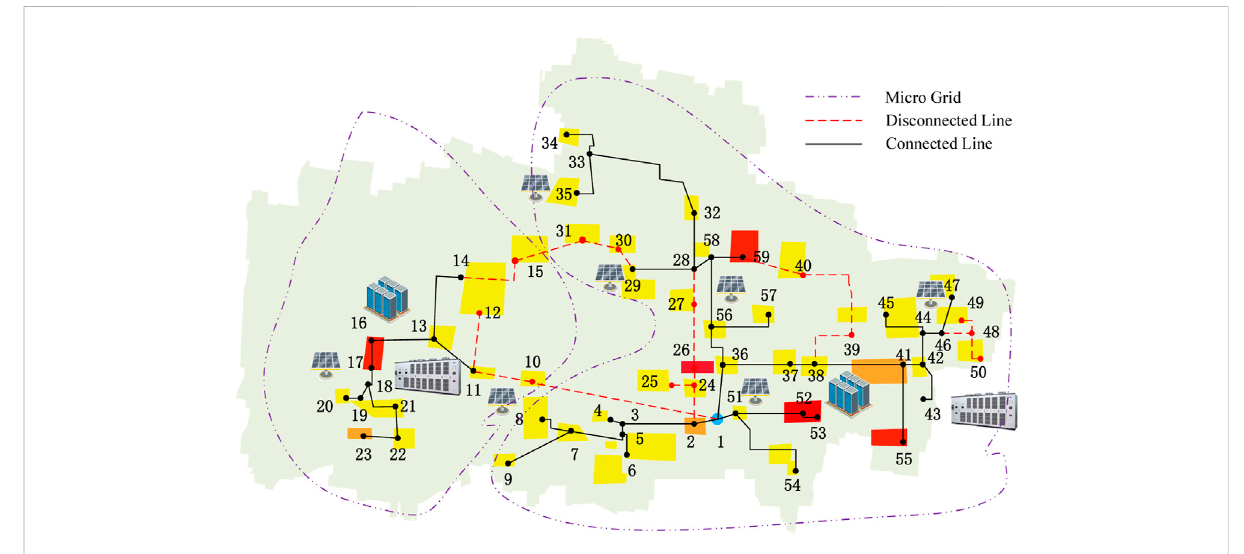
FIGURE 6 Island partition result of Case A.